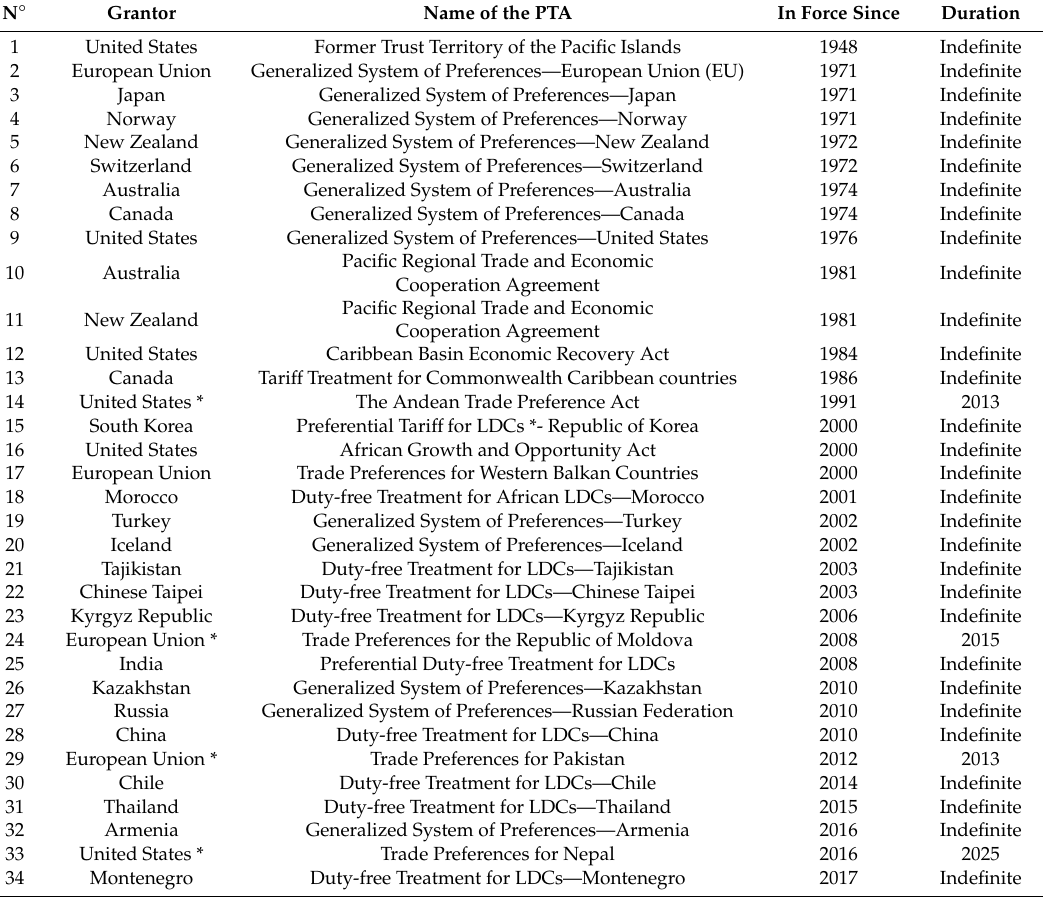
Table 2. Historical list of the preferential trade agreements (PTAs) registered under the World Trade Organization